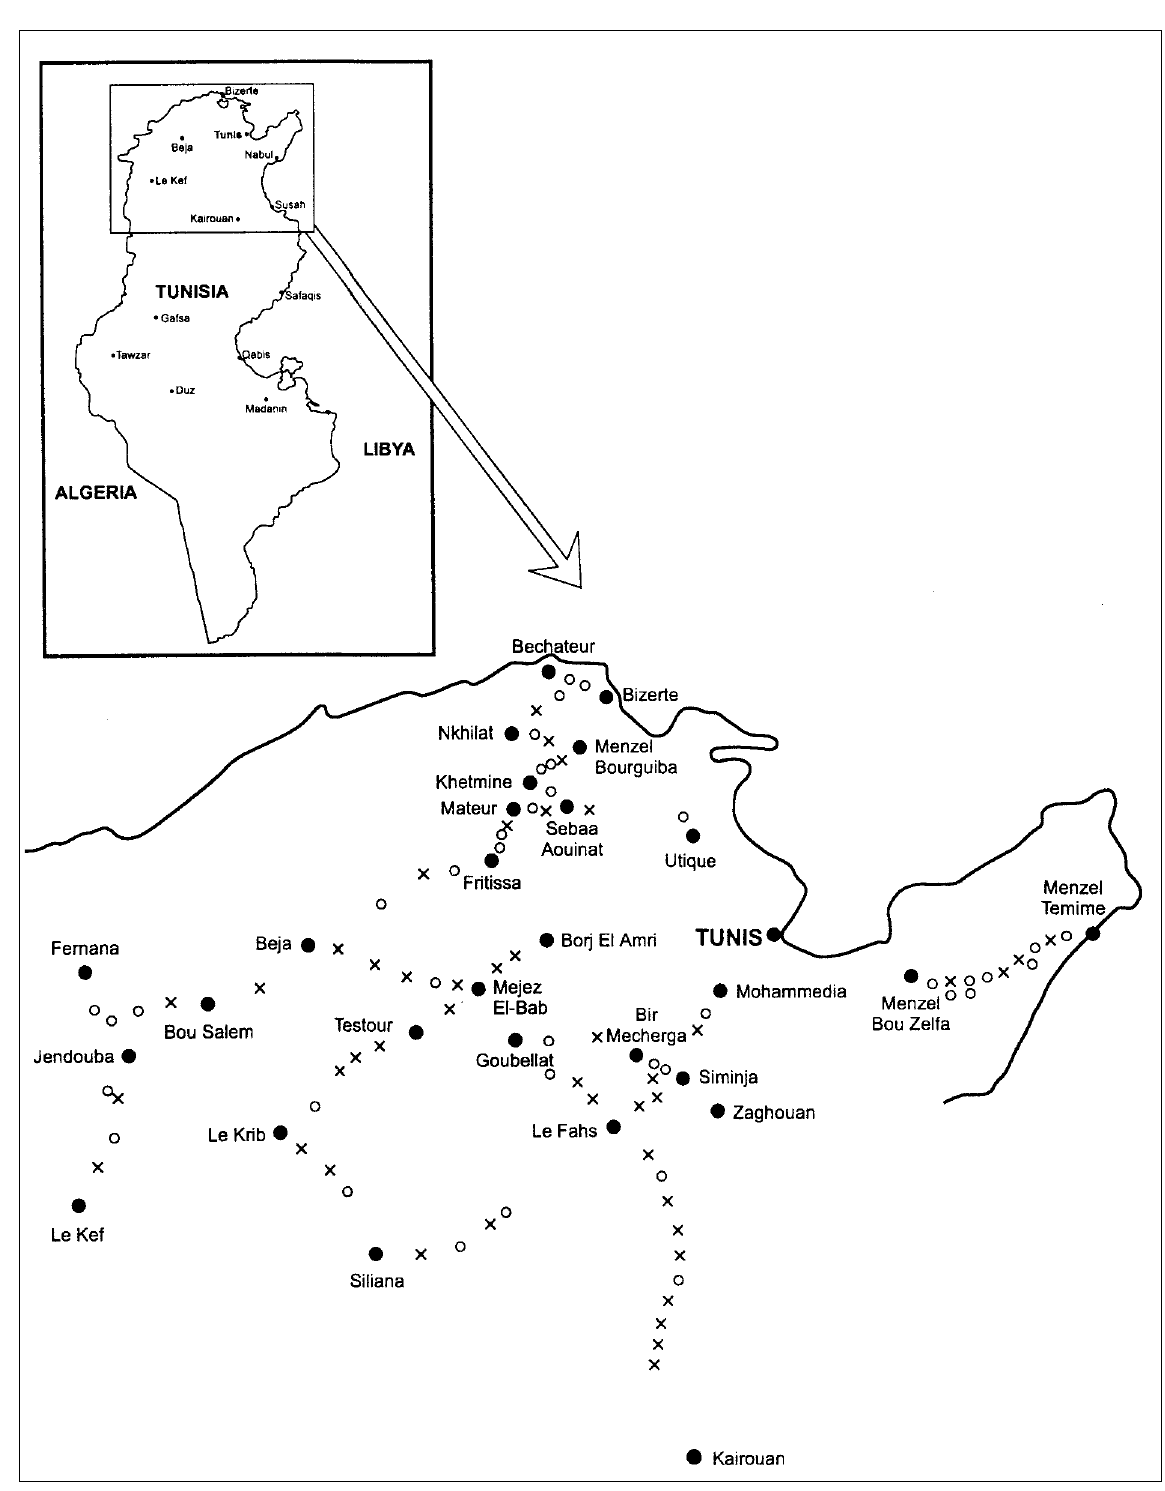
Fig. 1. Map of Tunisia showing the location of cereal ( (cid:1) ) and legume ( (cid:2) ) fields surveyed, April,